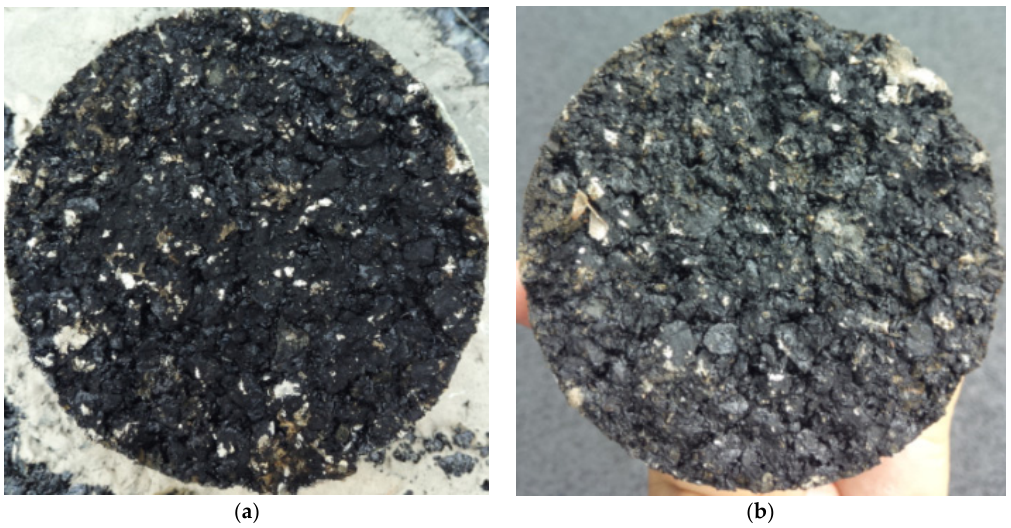
Figure 14. Field pull out test samples: ( a ) M ‐ UWM10; ( b ) SMA10 .